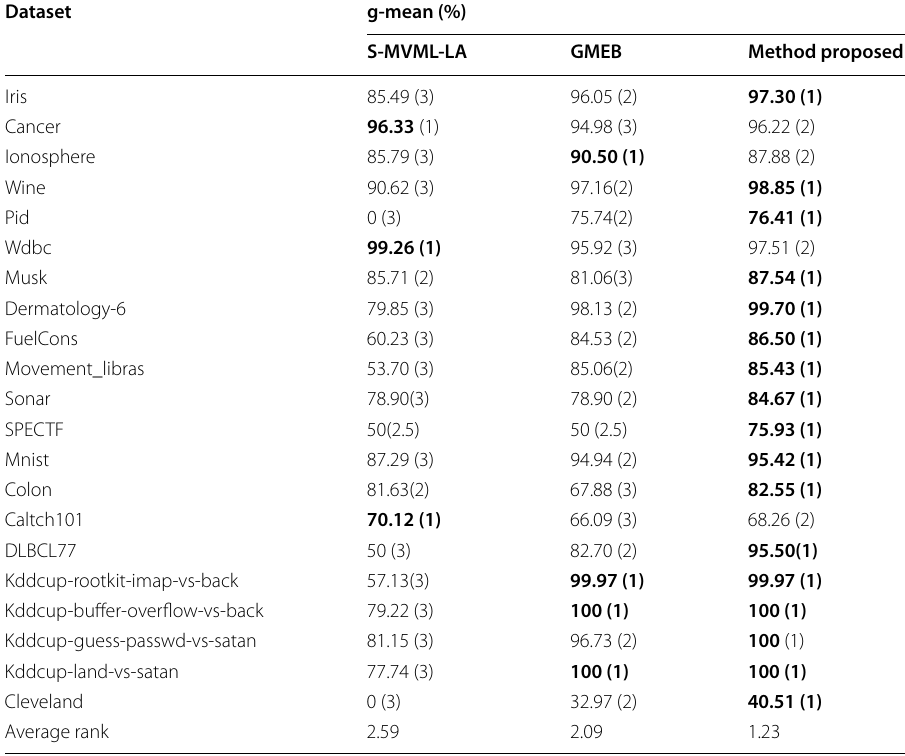
The numbers in bold are the best accuracies achieved on the dataset Table 10 Average runtime of the proposed method compared with other methods (in seconds)